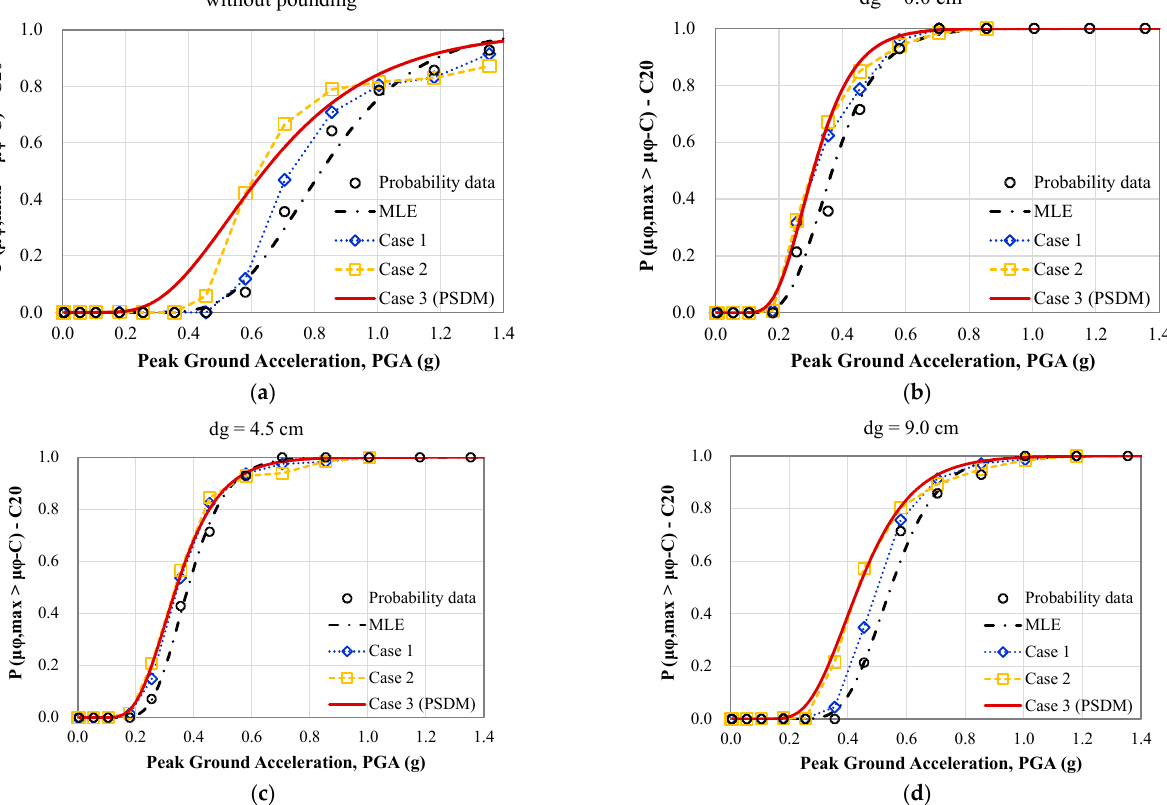
Figure 14. Influence of the PSDM assumptions on the fragility assessment of the eight-story RC frame in terms of μ φ ,max (C20) as a function of the PGA. Examined assumptions: Case 1—lognormality, Case 2—lognormality and power law model, Case 3—PSDM’s assumptions. Fragility curves ( a ) without the pounding effect, ( b ) d g = 0.0 cm, ( c ) d g = 4.5 cm, and ( d ) d g = 9.0 cm.